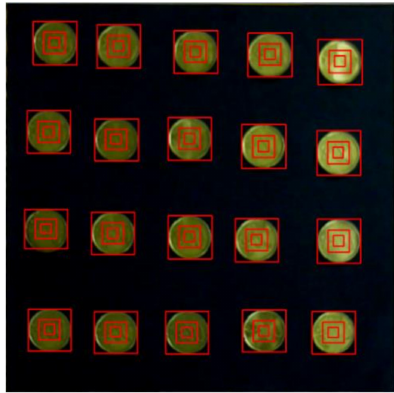
Figure 7. Coin training with 20 cent coins.